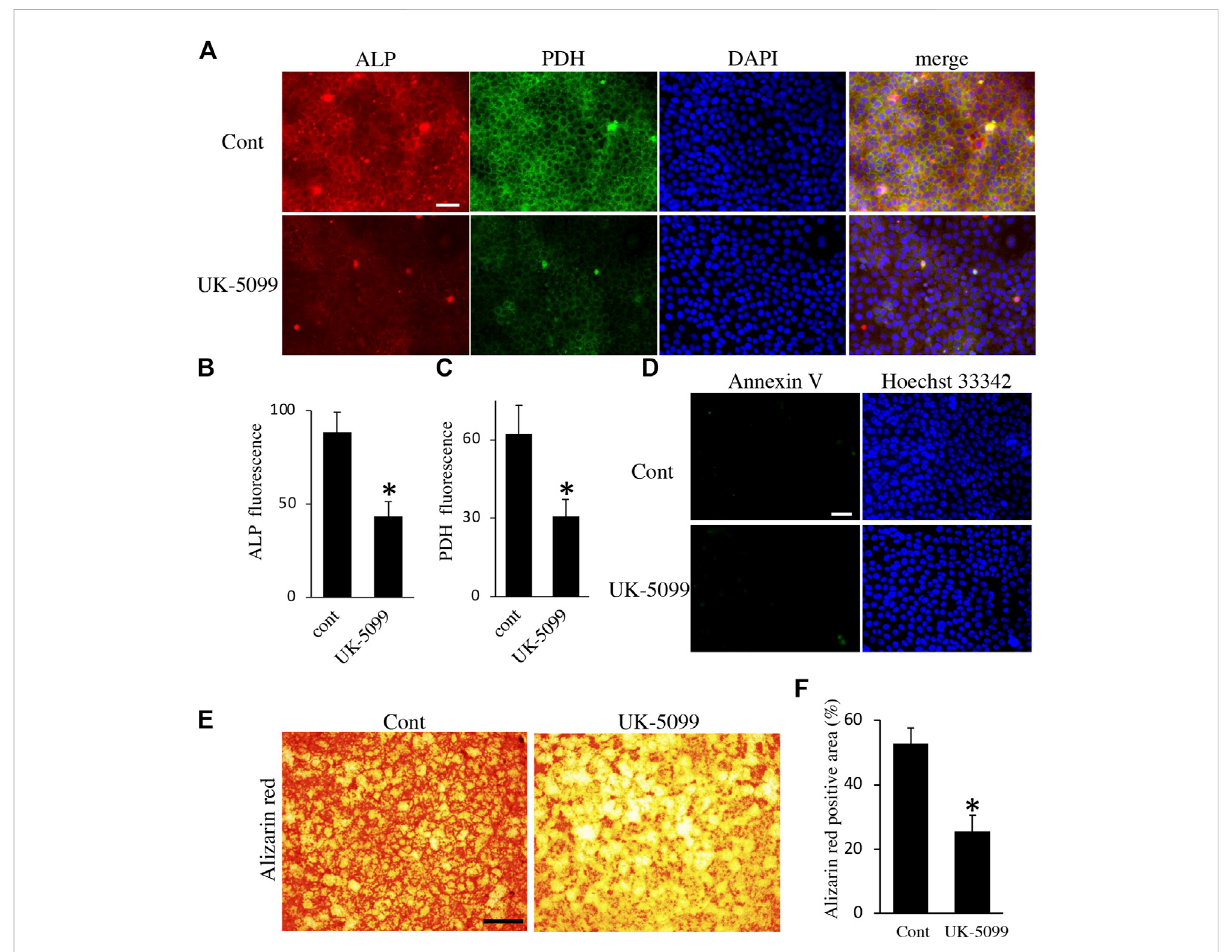
FIGURE 8 The effect of UK-5099 on mineralization. (A) Double staining of ALP and PDH in HAT7 cells treated with DMSO (upper: control) and 10 μ M UK- 5099 (lower) for 48 h. The nucleus is stained with DAPI(blue). Quanti fi cation of ALP (B) and PDH (C) fl uorescence; n = 3 each. (D) Annexin V staining ofHAT7cellsculturedwithDMSO(upper:control)and10 μ MUK-5099(lower)for48 h.ThenucleusisstainedwithHoechst33,342(blue). (E) Alizarin red staining of HAT7 cells cultured with DMSO (left: control) and 10 μ M UK-5099 (right) for 5 days. (F) Image analysis of the mineral coverage (Alizarin red positive) in the culture dish; n = 3. Data are represented as their mean ± SD. * p < 0.05 (unpaired two-tailed Student ’ s t -test). Scale bars, 50 μ m (A,D) ; 500 μ m (E)